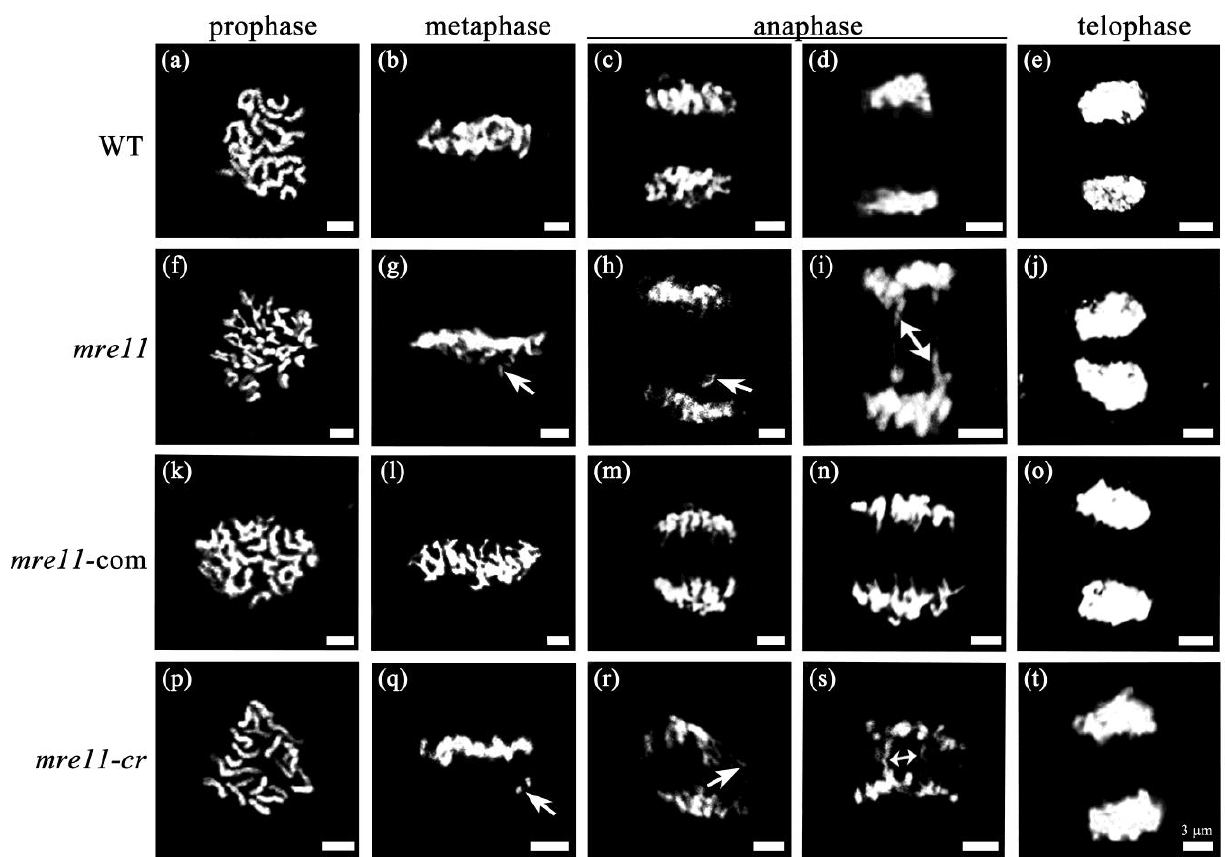
Figure 5. Chromosomal behavior of mitosis in WT and the mutants of rice. The root tip cells were detected in 7DAG seedlings of WT, mre11 , mre11 -com, and mre11-cr . ( a – e ) Chromosomal behavioral characteristics of prophase, metaphase, anaphase, and telophase in WT. ( f – j ) Chromosomal behavioral characteristics of prophase, metaphase, anaphase, and telophase in the mre11 . ( k – o ) Chromosomal behavioral characteristics of prophase, metaphase, anaphase, and telophase in the mre11 -com. ( p – t ) Chromosomal behavioral characteristics of prophase, metaphase, anaphase, and telophase in the mre11-cr . ( g , h , q , r ) One sided arrows showed lagging chromosomes during metaphase and anaphase. ( i , s ) Double sided arrows showed chromosome bridges during anaphase. Scale bars represent 3 µm.